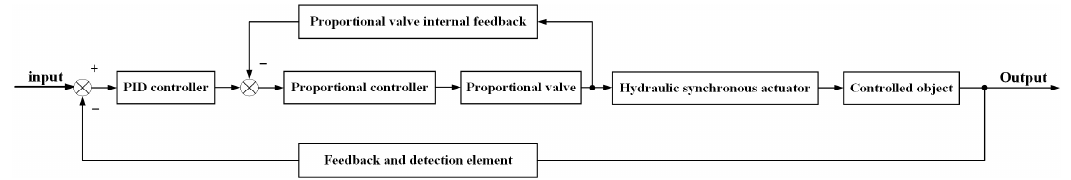
Figure 7. Block diagram of electro-hydraulic proportional hydraulic synchronization control system.